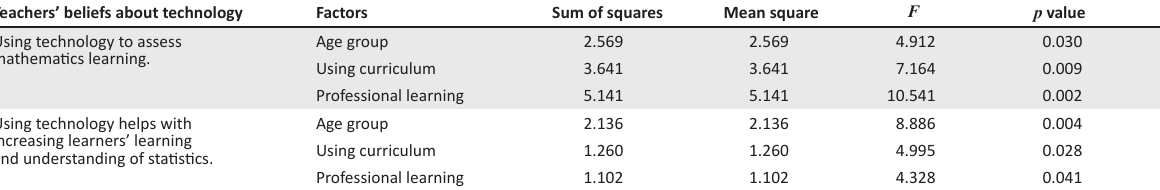
TABLE 8: Teachers’ beliefs about technology and effect of demographic